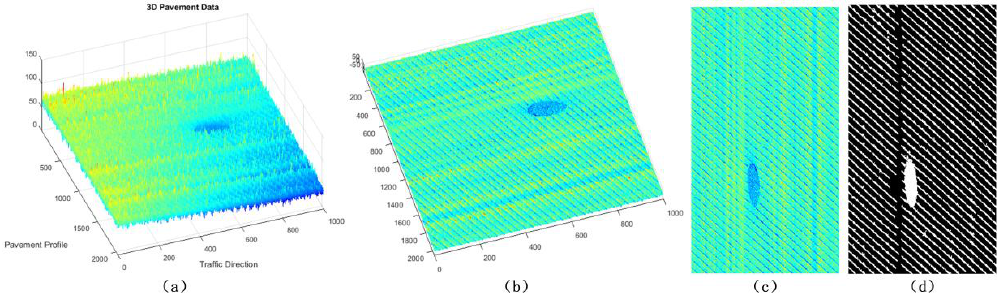
Figure 18. The 3D airport asphalt pavement Data 1 and corresponding sparse components, ( a ) 3D data from airport asphalt pavement, ( b ) ( c ) corresponding sparse components, ( d ) pavement groove information extracted from sparse components.